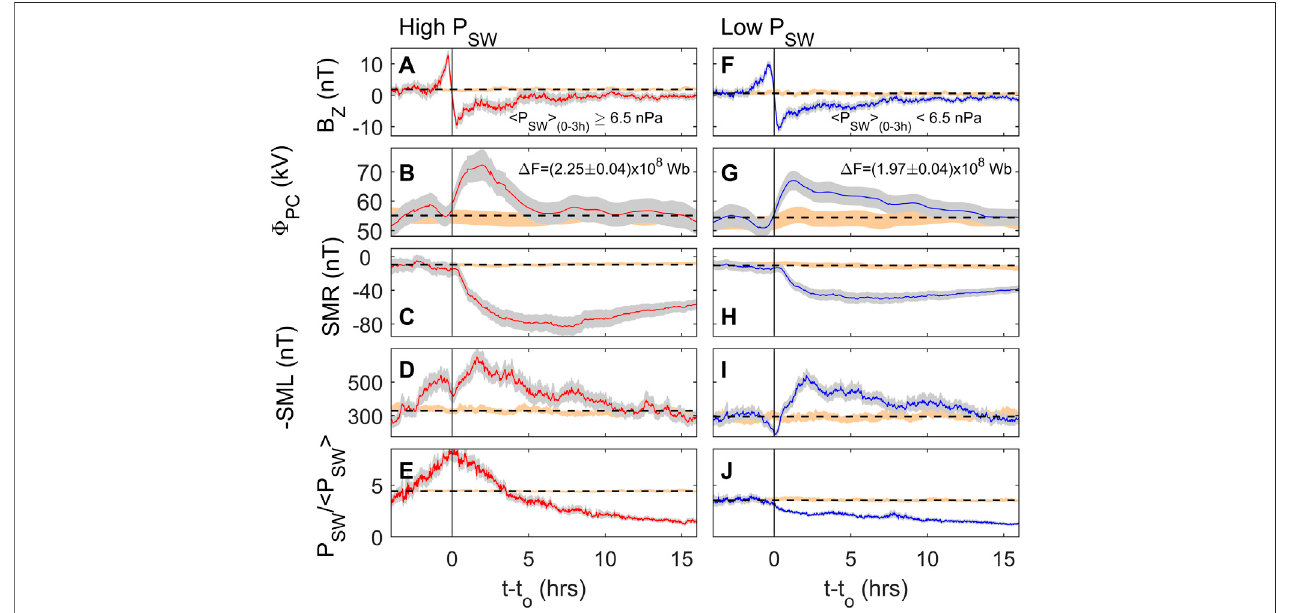
FIGURE 9 | Superposed epoch study illustrating the effect of solar wind dynamic pressure, P SW , on the events discussed in Figure 5 . The southward turning are dividedintotwosets with P SW ,averaged over the3 hafter the southward turning, < P SW > (0 – 3h) , exceeding orless than 6.5 nPa, thatbeing thethreshold thatdivides the dataintotwoequalsets of80events. Theformatisasin Figure5 withlefthandpanels(andred lines)for < P SW > (0 – 3h) ≥ 6.5 nPaand right-handcolumns(andblue lines) for < P SW > (0 – 3h) < 6.5 nPa. The bottom panels are the superposed epoch plots of the solar wind dynamic pressure, P SW .